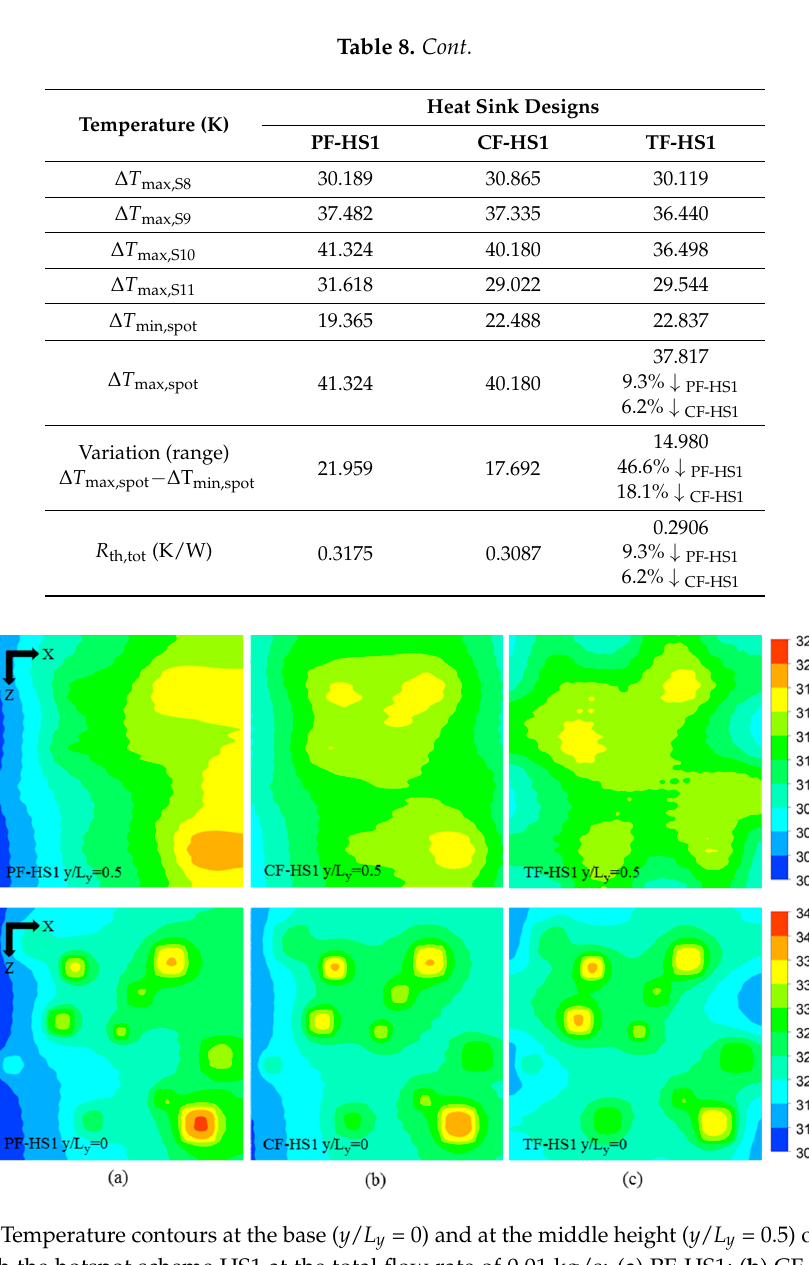
Figure 7. Temperature contours at the base ( y / L y = 0) and at the middle height ( y / L y = 0.5) of the heat sinks with the hotspot scheme HS1 at the total flow rate of 0.01 kg/s: ( a ) PF-HS1; ( b ) CF-HS1; and ( c ) TF-HS1.